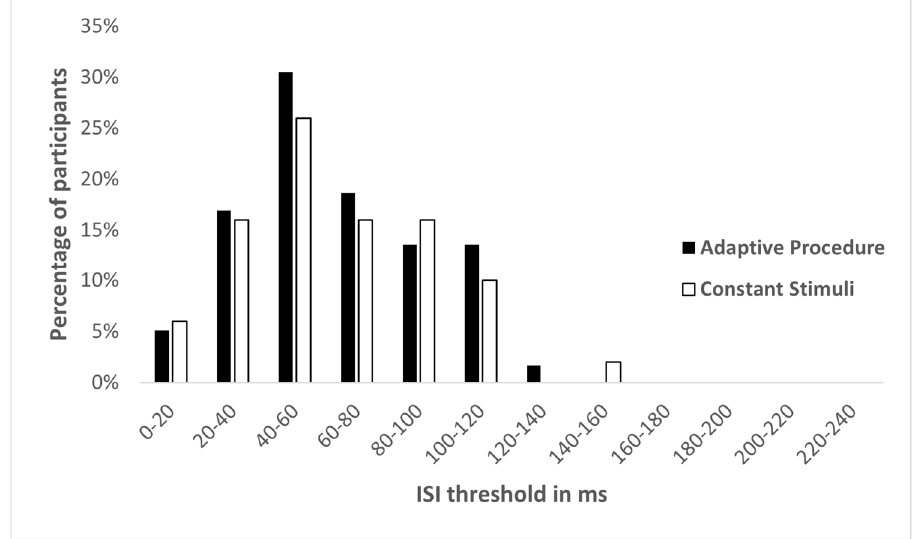
Figure 1. Threshold distribution for spatial TOJ in adaptive procedure and method of constant stim- uli.